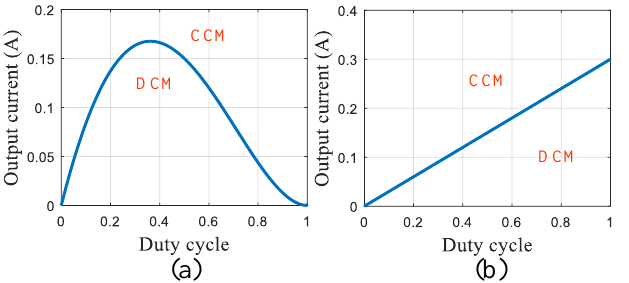
Figure 5. The operating region of the converter in continuous/discontinuous conduction mode; ( a ) the constant output voltage, ( b ) the constant input voltage. CCM and DCM voltage gain relations are not the same. Considering D as the duty cycle and D1 as the ratio of the ON time of the last diode over the whole switching period, the expressing voltage gain of DCM can be expressed as